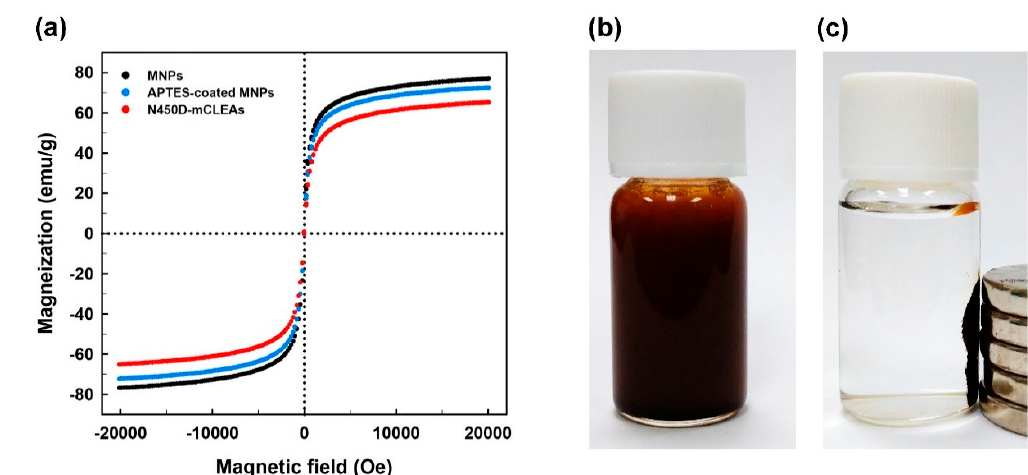
Figure 5. Magnetic hysteresis curves of bare and APTES-coated MNPs, and N450D-mCLEAs ( a ), dispersivity of N450D- mCLEAs in Tris-HCl buffer ( b ), and the collection of N450D-mCLEAs by an external magnetic field ( c ).